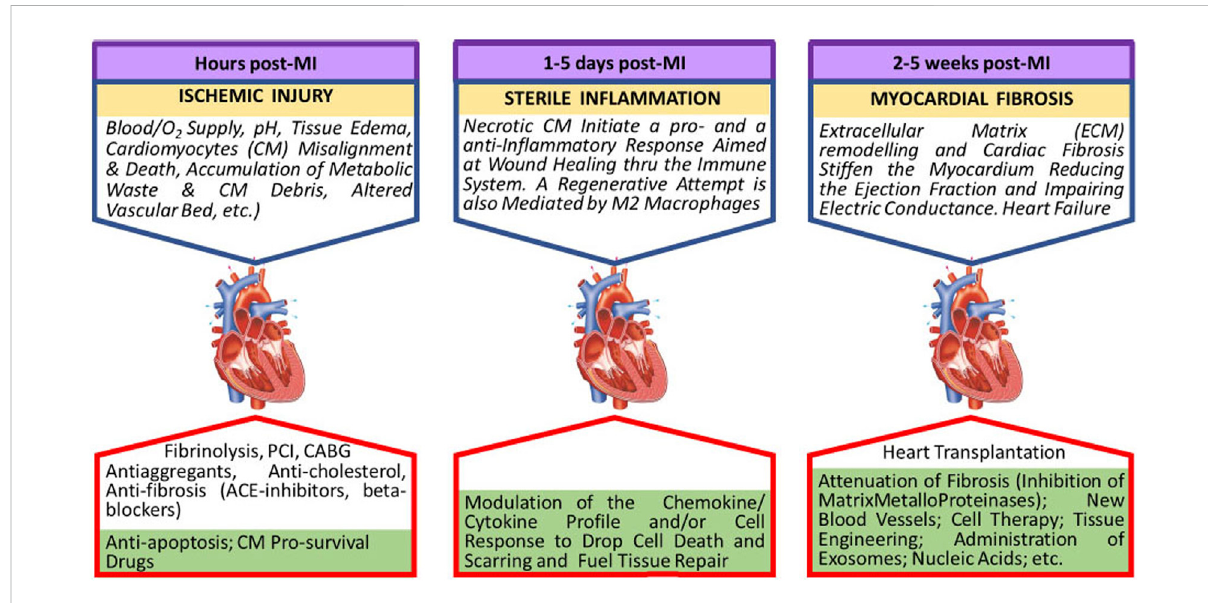
FIGURE 2 Evolution of the myocardial ischemic damage. In lower green boxes future research directions are